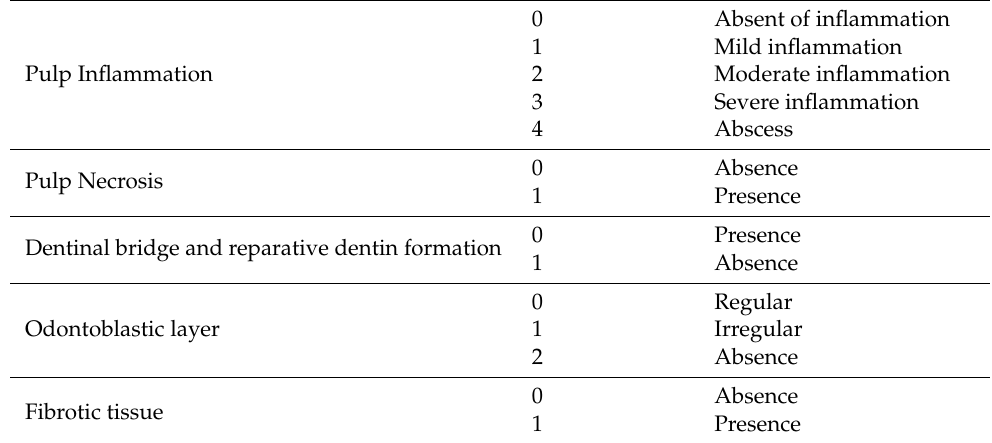
Table 1. Scores attributed for the levels of the histological criteria evaluated.